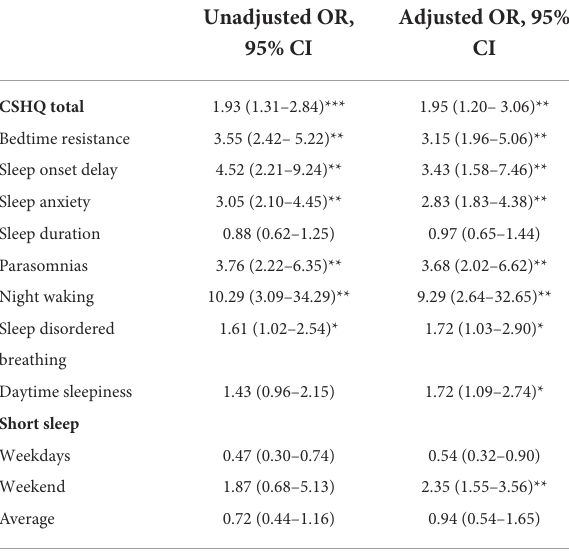
TABLE 4 The association of TD with sleep disturbances and short